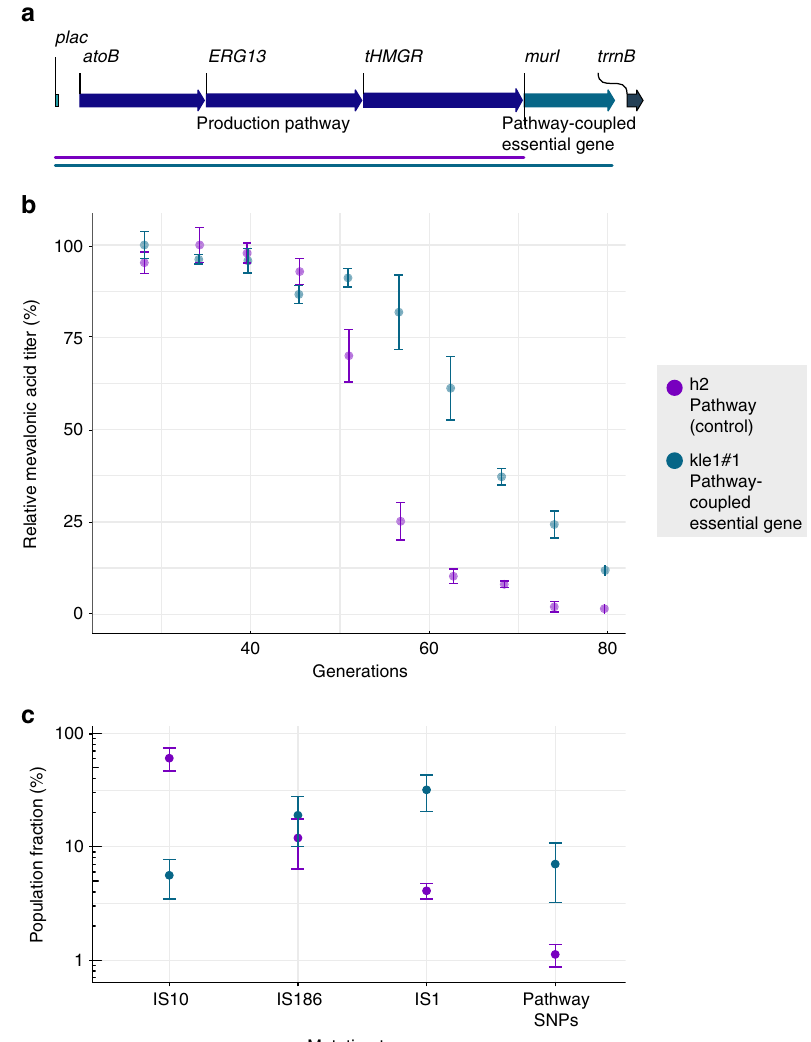
Fig. 6 Pathway-coupled essential gene reshapes the long-term production error pro fi le. a Genetic pathway design of control ( h2 ) and transcriptionally coupled essential pathway gene ( kle1#1 ). b Mevalonic acid titers (relative to earliest point) (Supplementary Table 3) in experimentally simulated fermentations of control pMevT h2 and pathway-coupled essential gene strain kle1#1 (Supplementary Table 9). c Fraction (%) in pathway population of the three most abundant pathway-disrupting IS types, compared to summed frequencies of pathway SNPs (Supplementary Table 10). Error bars denote s.e.m. ( n